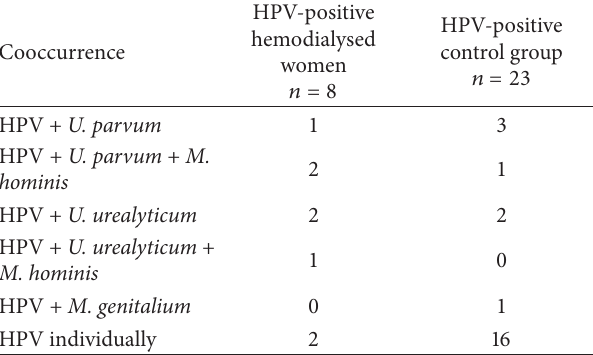
Table 3: Cooccurrence of mycoplasmal species in HPV-positive hemodialysed women and control